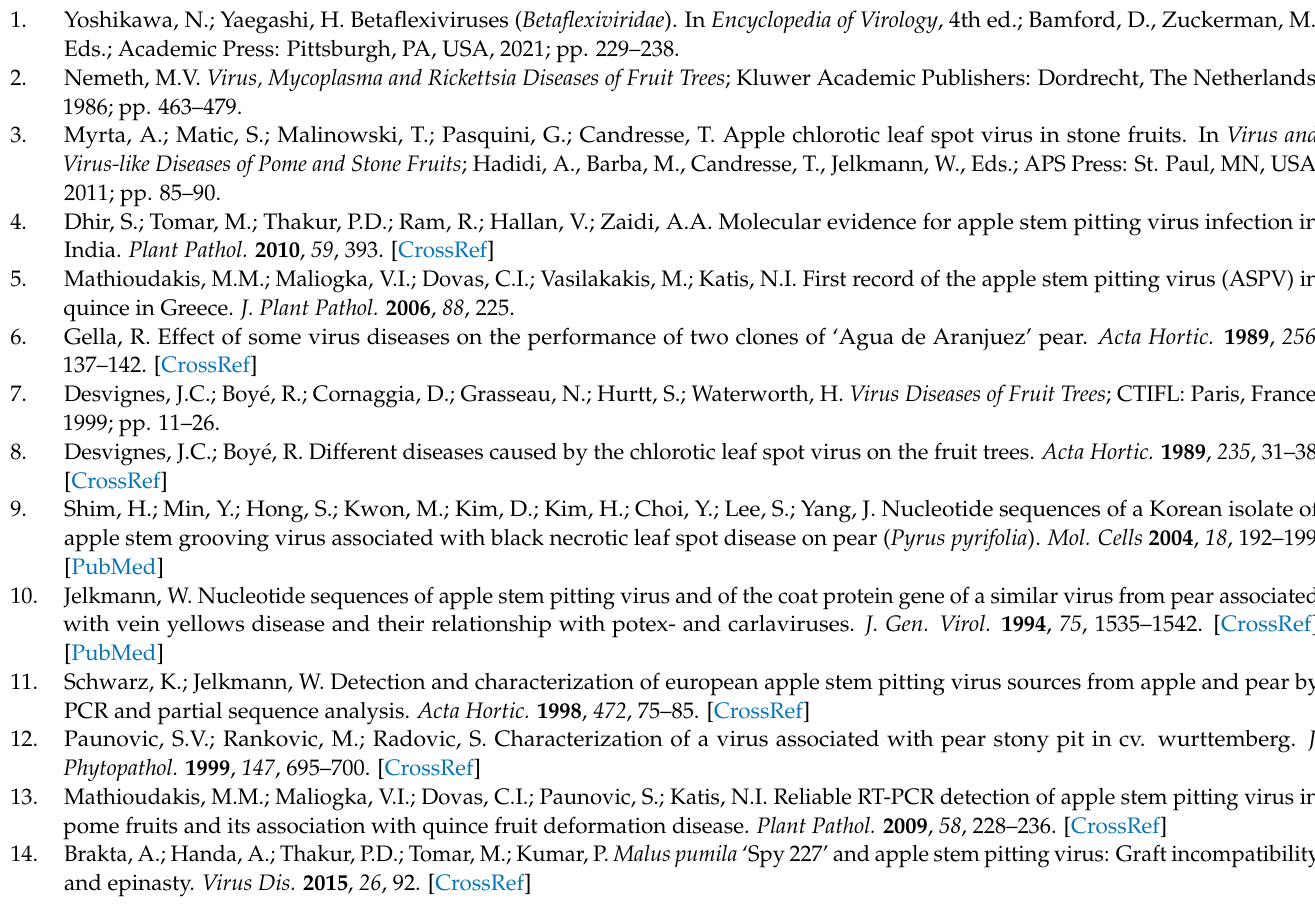
Table S4. Contigs assembled from RNA-seq derived